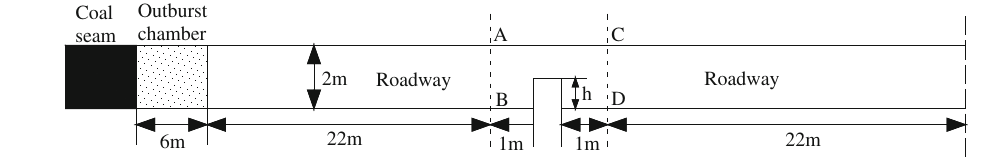
Fig. 14 Geometry of blocked